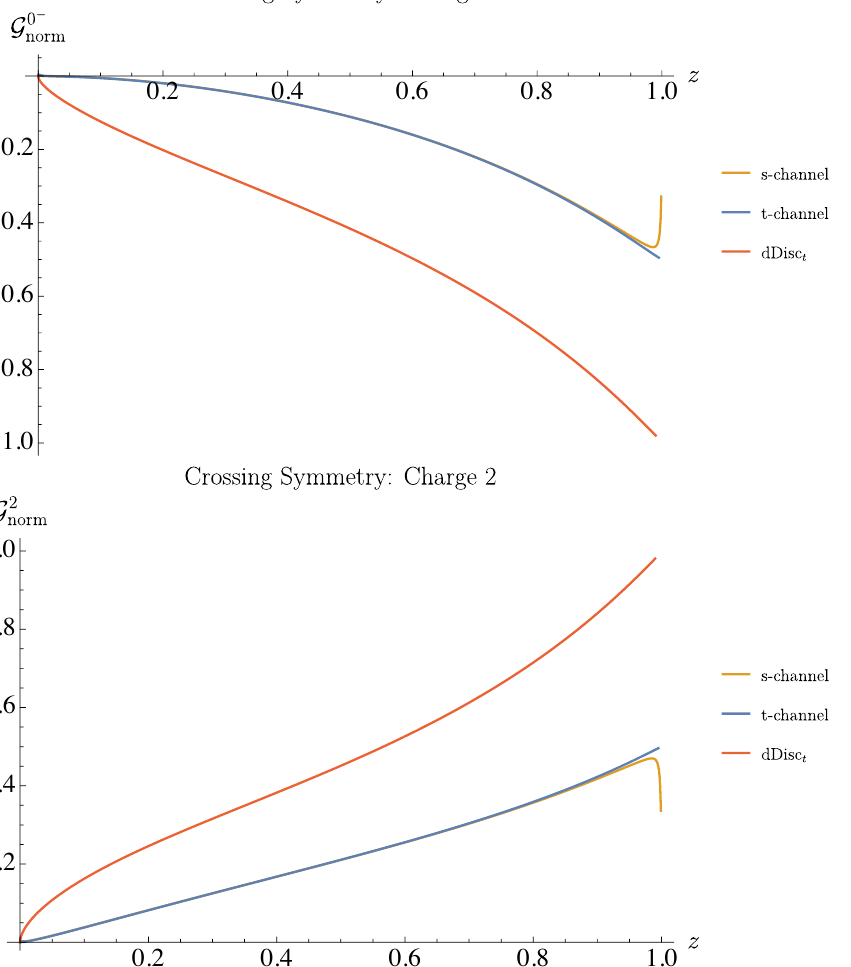
Figure 20 . We study h (cid:30)(cid:30)(cid:30)(cid:30) i and project onto charge 0 (cid:0) and charge 2 exchange in the s -channel. We compare the prediction for the full normalized correlator on the diagonal, G 0 (cid:0) ; 2 s and t -channel OPEs. We also plot its dDisc t , which is computed using the t -channel OPE. intercepts by continuing the physical trajectories down to (cid:1) = 3 = 2. Alternatively,